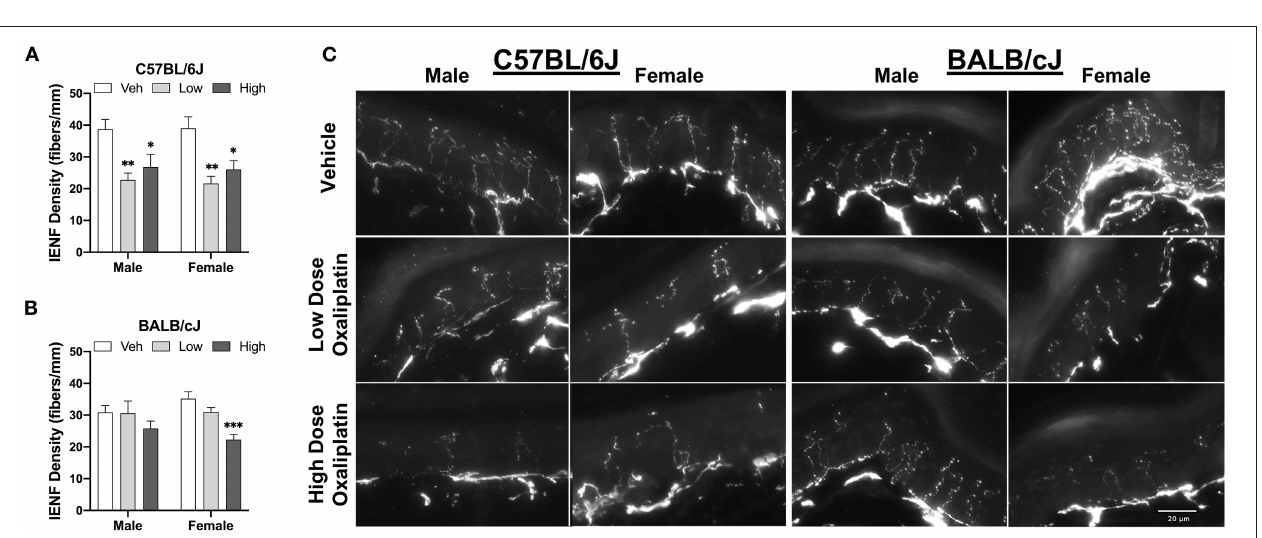
FIGURE 10 | Reduction of intraepidermal nerve fiber density in the hind paw at week 11. (A) shows C57BL/6J males and females ( n = 6/group), while changes to IENF density in BALB/cJ males and females ( n = 6/group) are shown in (B) . Representative fluorescence microscopic images of IENF taken at 40X (C) . Values are expressed as mean ± SEM. Overall effects of oxaliplatin treatment per sex of each strain were identified using one-way ANOVA Treatment) for each strain and for each sex, and post-hoc Dunnet’s test (* p < 0.05; ** p < 0.001; *** p <